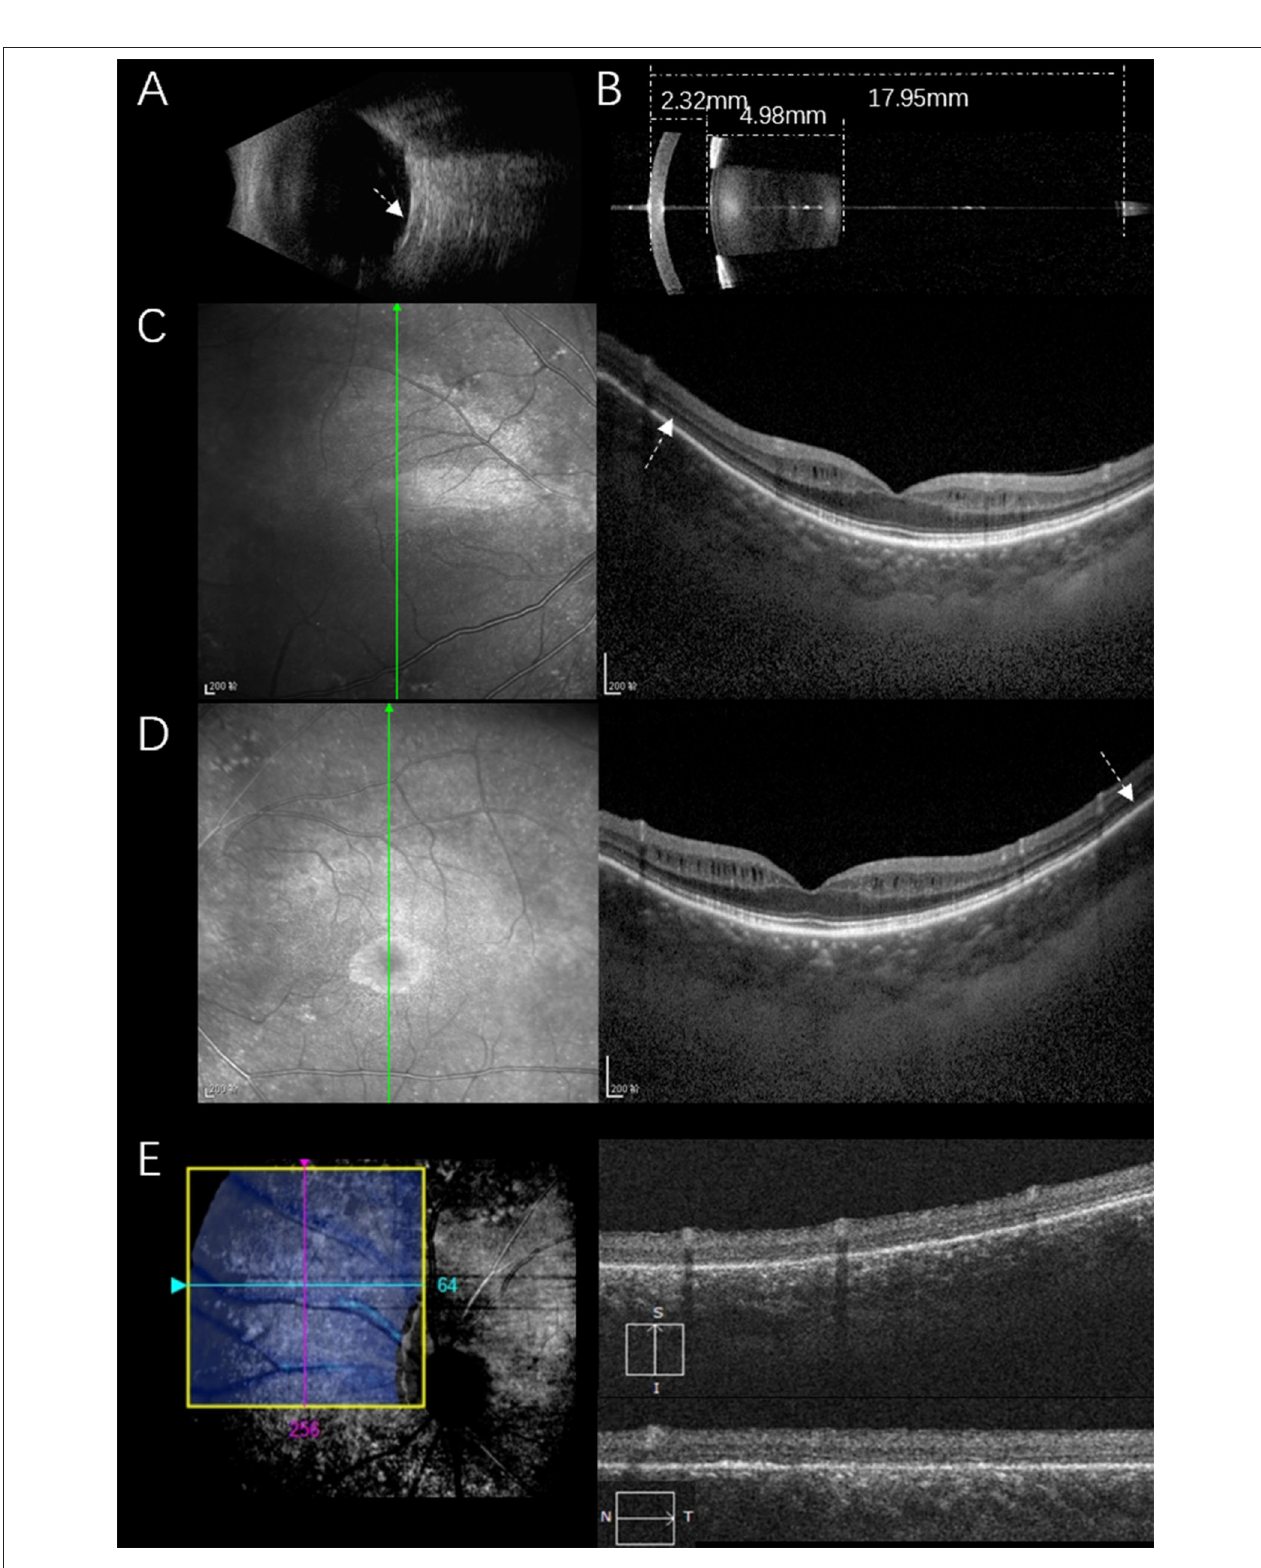
FIGURE 2 | Ocular biometric measurement and OCT scan for the proband. B-mode ultrasonography showed a short eye axis, scleral thickening [white arrow in (A) ] and IOL-Master results showed that the anterior chamber depth was 2.32mm, the lens thickness was 4.98mm, and the axial length was 17.95mm (B) . OCT